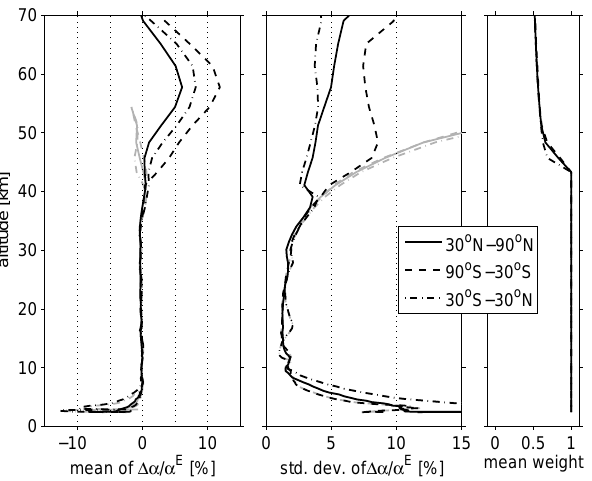
Fig. 11. Statistical comparison of 15327 IGOR (TerraSAR-X) re- fractivity profiles with collocated ECMWF analysis results. The observation period is 24 July to 17 November 2008; the data is pro- cessed by by GFZ’s experimental processing system POCS-X us- ing single differencing. Left: mean fractional refractivity error for three meridional zones, 90 ◦ S–30 ◦ S (dashed lines), 30 ◦ S–30 ◦ N (dashed-dotted), 30 ◦ N–90 ◦ N (solid). Center: standard deviation of the fractional refractivity error. Right: number of data